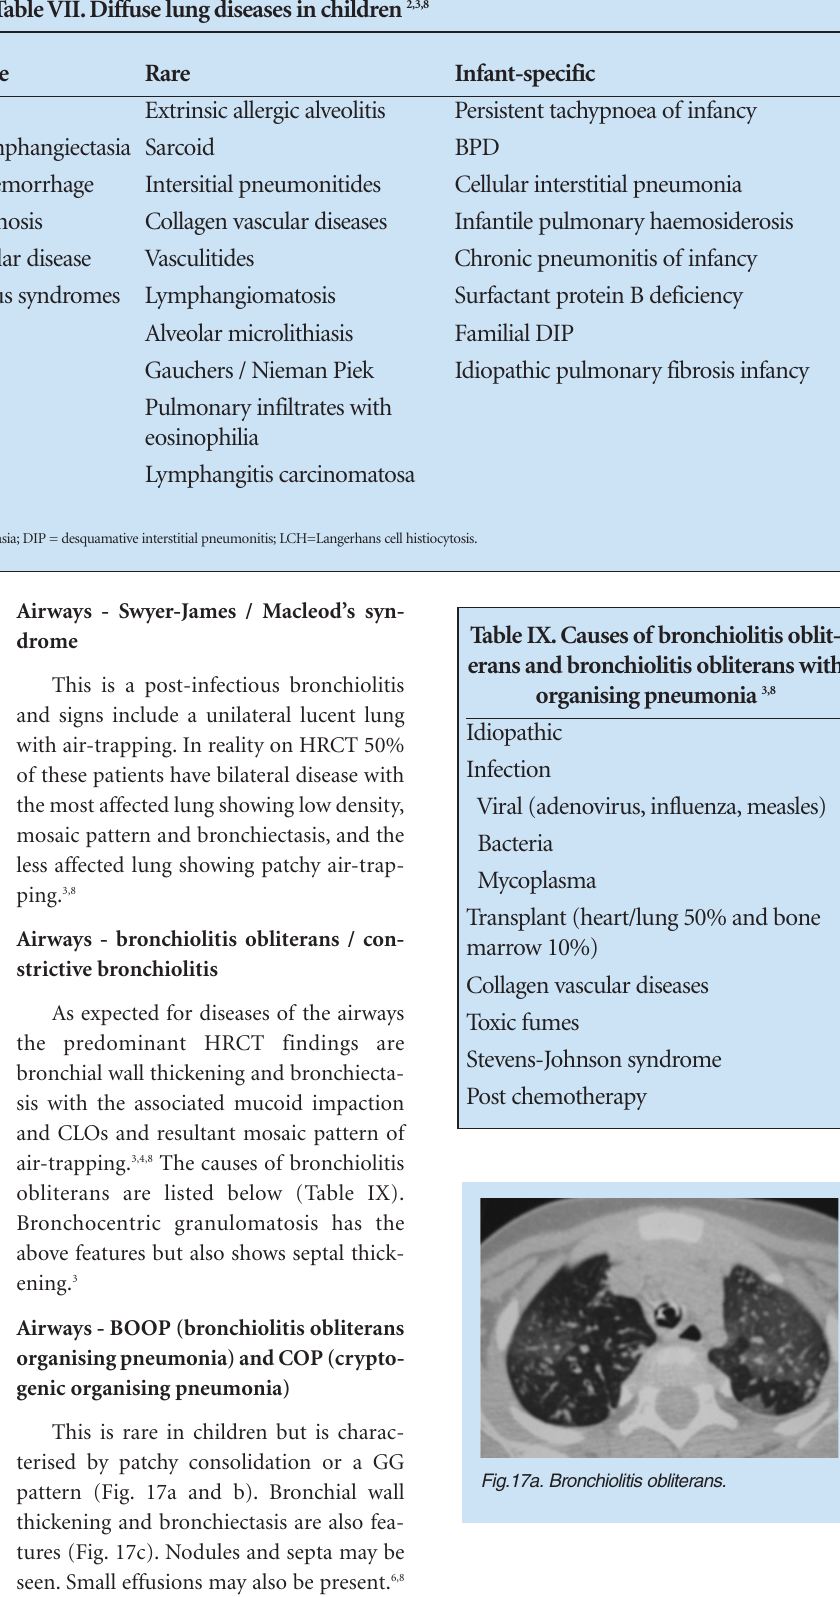
Table VII.Diffuse lung diseases in children 2,3,8